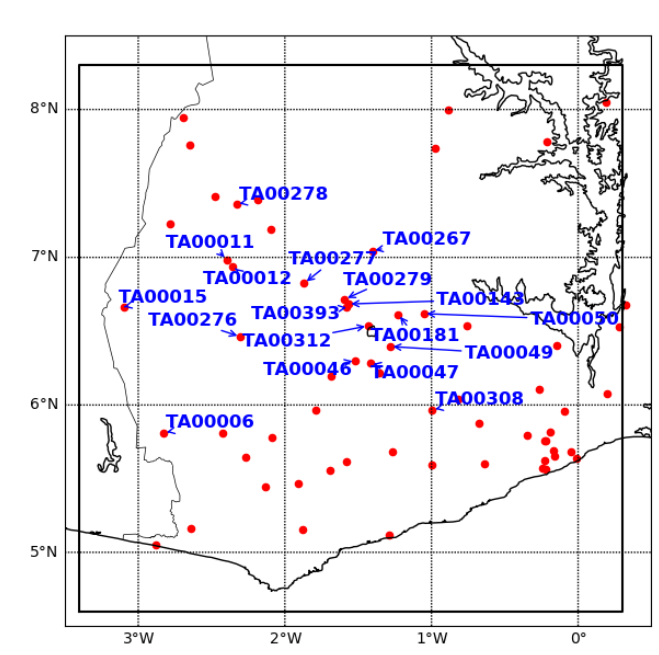
Figure A1. Position of all the TAHMO stations mentioned in this